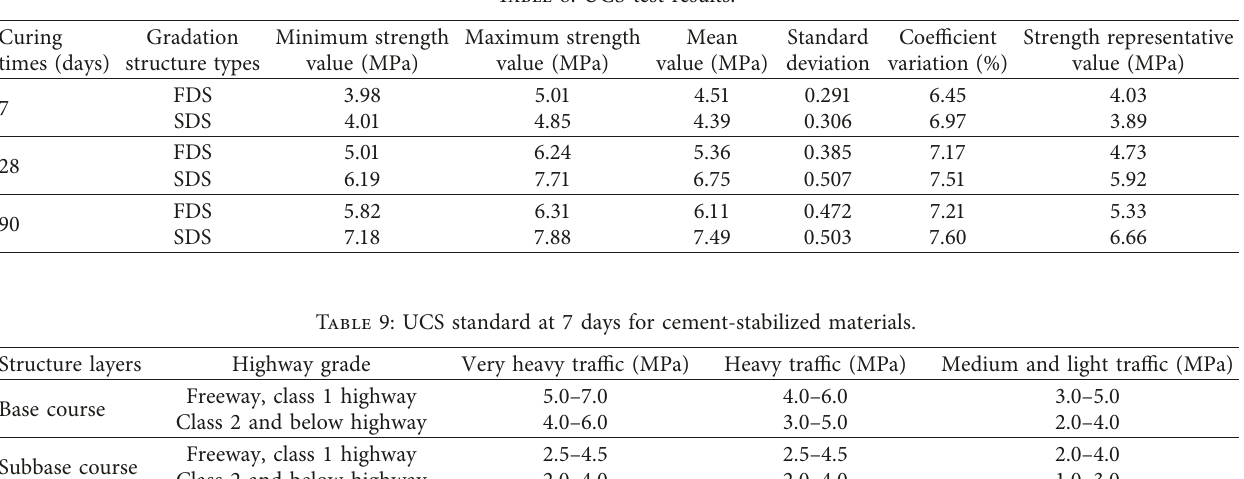
Figure 13: Freezing-thawing test: (a) appearance of SDS before freeze-thaw cycle, (b) appearance of FDS before freeze-thaw cycle, (c) appearance of SDS after 5 freeze-thaw cycles, and (d) appearance of FDS after 5 freeze-thaw cycles. Table 8: UCS test results.